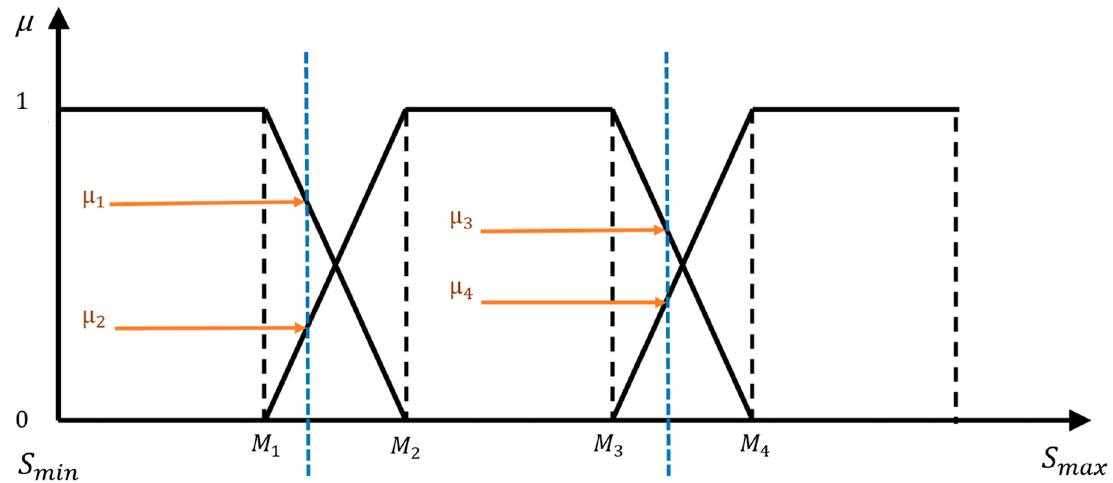
Figure 3. Trapezoidal membership function for fuzzy hedging coefficients.